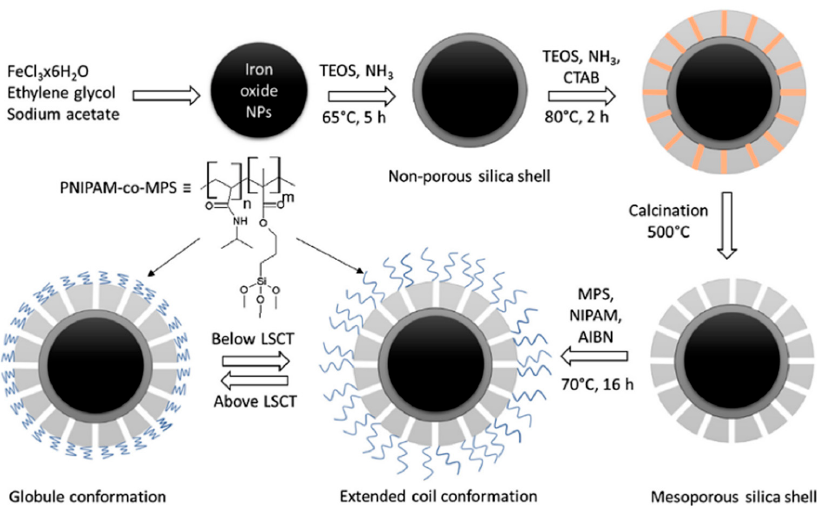
Figure 11. Preparation of polymer coated magnetic MSNs for delivery of Ibuprofen. Reproduced with permission from reference [51].